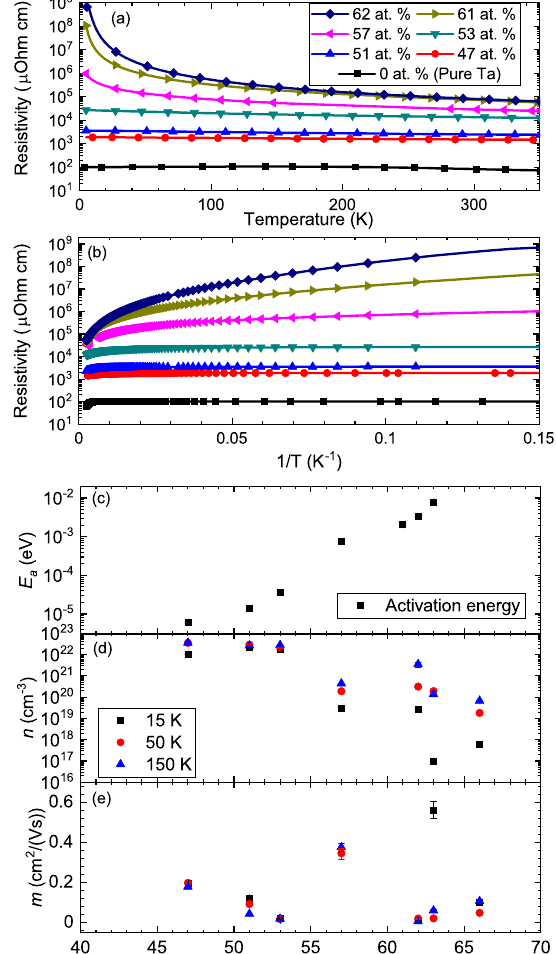
Figure 5. ( a ) Temperature dependence of the electrical resistivity of TaO x films with different O content, including a reference film of pure Ta. Above ∼ 55 at.% of O, the films start exhibiting semiconductor–like behavior (i.e., a decrease in resistivity with increasing temperature), consistent with conduction dominated by activated tunneling and defect states in the oxide phase. An Arrhenius plot used to extract activation energy ( E a ) is presented in ( b ), while resulting energies are shown as a function of O content in ( c ). For clarity, only every 100th data point is marked with a symbol in ( a , b ), and the legend in ( a ) applies to ( b ) also. The carrier density ( n ) and mobility ( µ ) extracted from Hall effect measurements are plotted in ( d , e ), respectively, with temperature of the measurement indicated in the legend in ( d ), which applies to both panels ( d , e ). The carrier density is largely independent of temperature for low O content films but exhibits pronounced variations with temperature as O content increases. Error bars arise from uncertainty in fits to the high–field Hall data. In most cases, error bars are comparable to the size of the symbols due to multiple scans being averaged to improve data